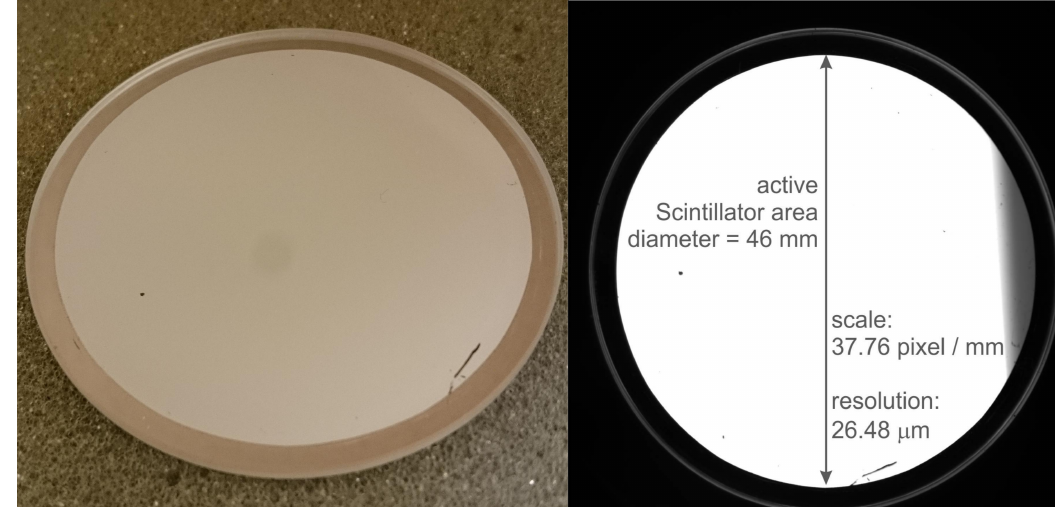
Figure 7. Photograph and schematic of the phosphor screen used for imaging the beam. The screen was composed of a P43 phosphor surface on a substrate of aluminised pyrex, and the scale and resolution of the screen are shown on the schematic.